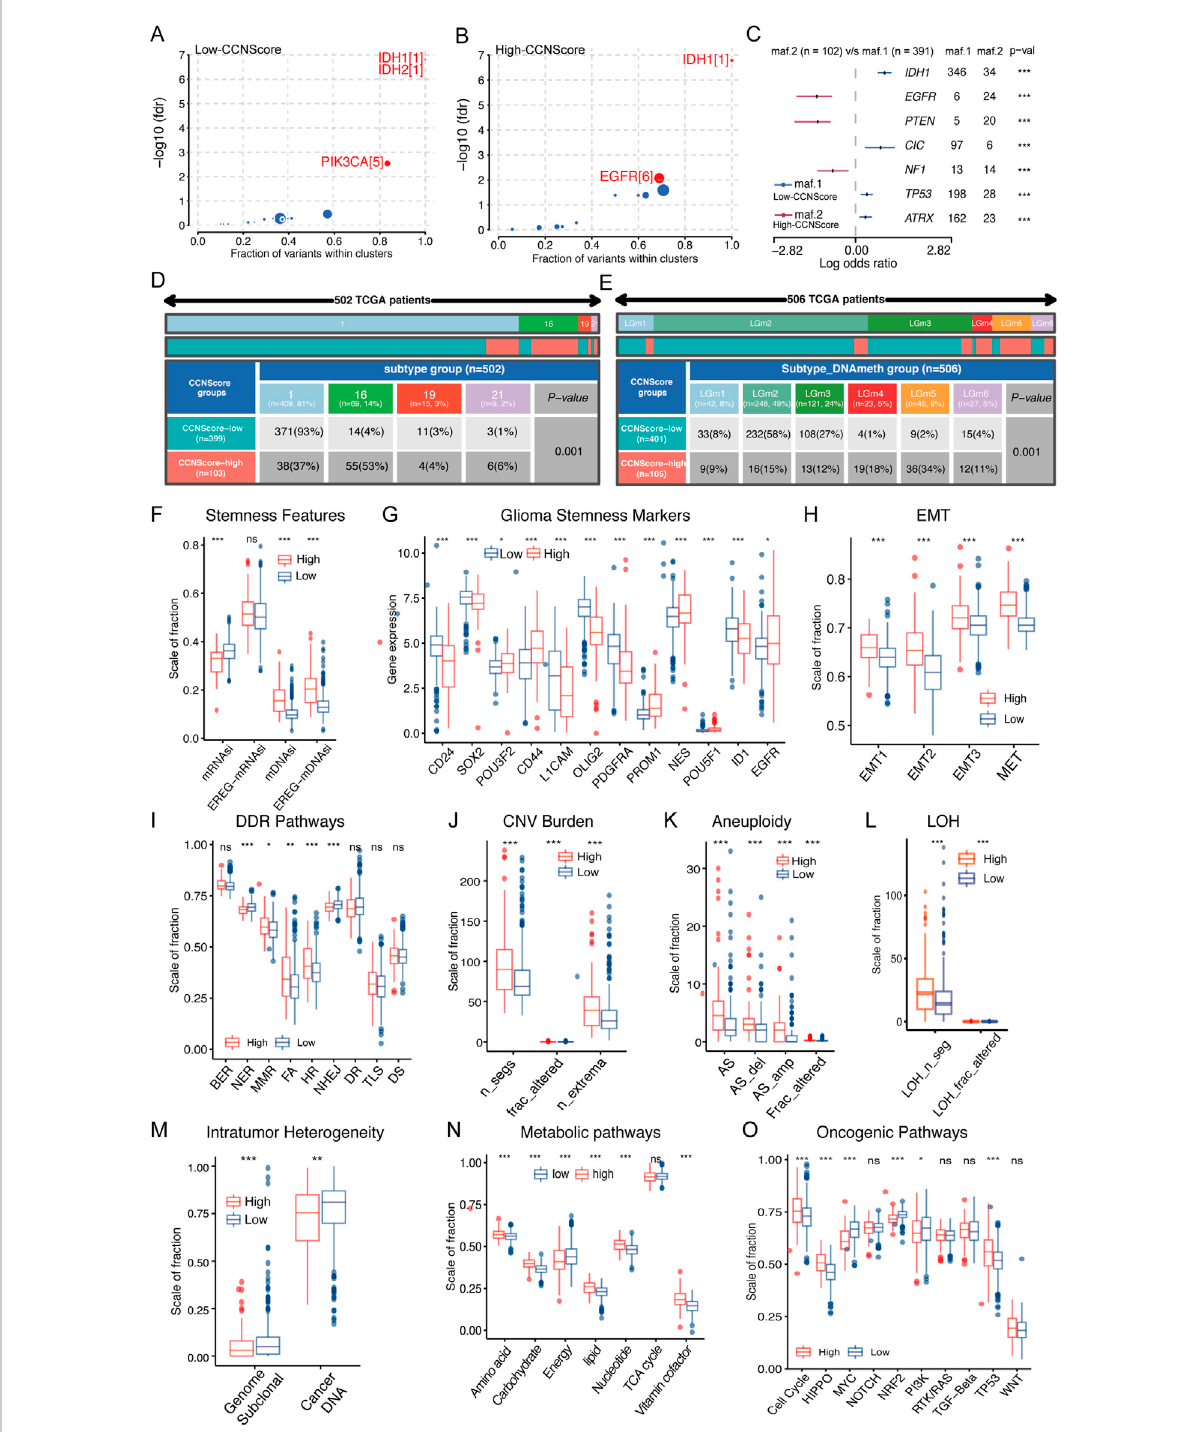
FIGURE 5 Relationship between CCNScore and the development of LGG. (A,B) Bubble plot shows the driver genes of Low-CCNScore (A) and High- CCNScore (B) groups. (C) Forest plot shows the differential mutation patterns in the Low-CCNScore and High-CCNScore groups. (D,E) Pan-cancer methylation subtypes (D) and Pan-glioma methylation subtypes (E) of Low-CCNScore and High-CCNScore groups. (F – H) Differences in stemness index (F) , markers of glioma stem cells (G) , and EMT versus MET phenotype (H) between Low-CCNScore and High-CCNScore groups. (I – M) Differences in DNA damage repair pathways (I) , copy number variation burden (J) , aneuploidy (K) , loss of heterozygosity (L) and intratumor heterogeneity (M) betweenLow-CCNScoreandHigh-CCNScoregroups. (N)